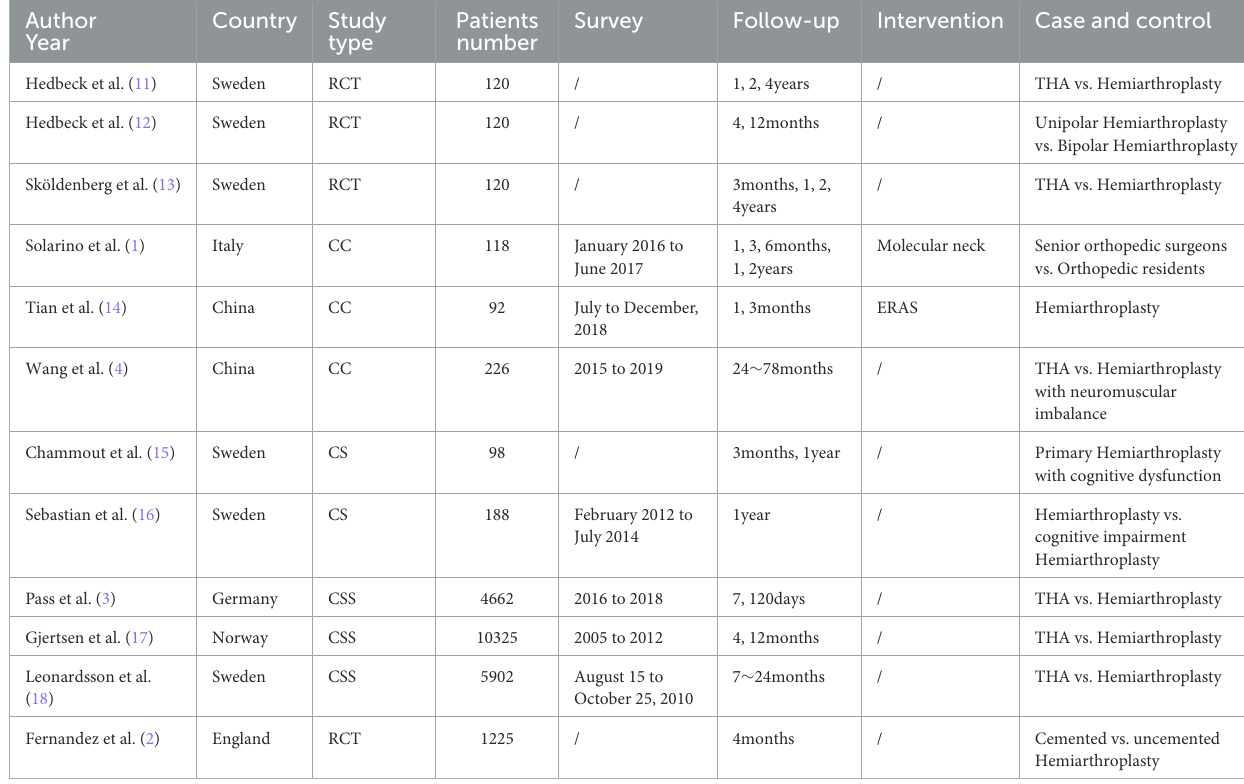
TABLE 1 Baseline data and quality evaluation of the 12 included